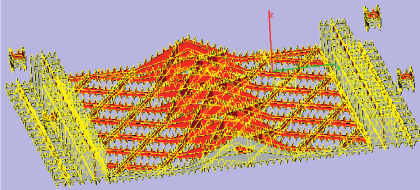
Figure 7: Support volume generated by Magic 18 software [24].